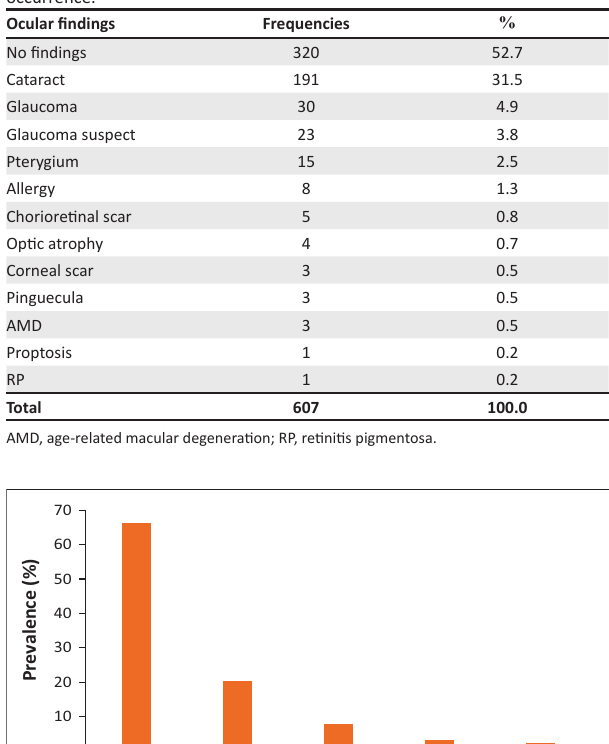
TABLE 5: Association between sociodemographic factors and hyperopia.